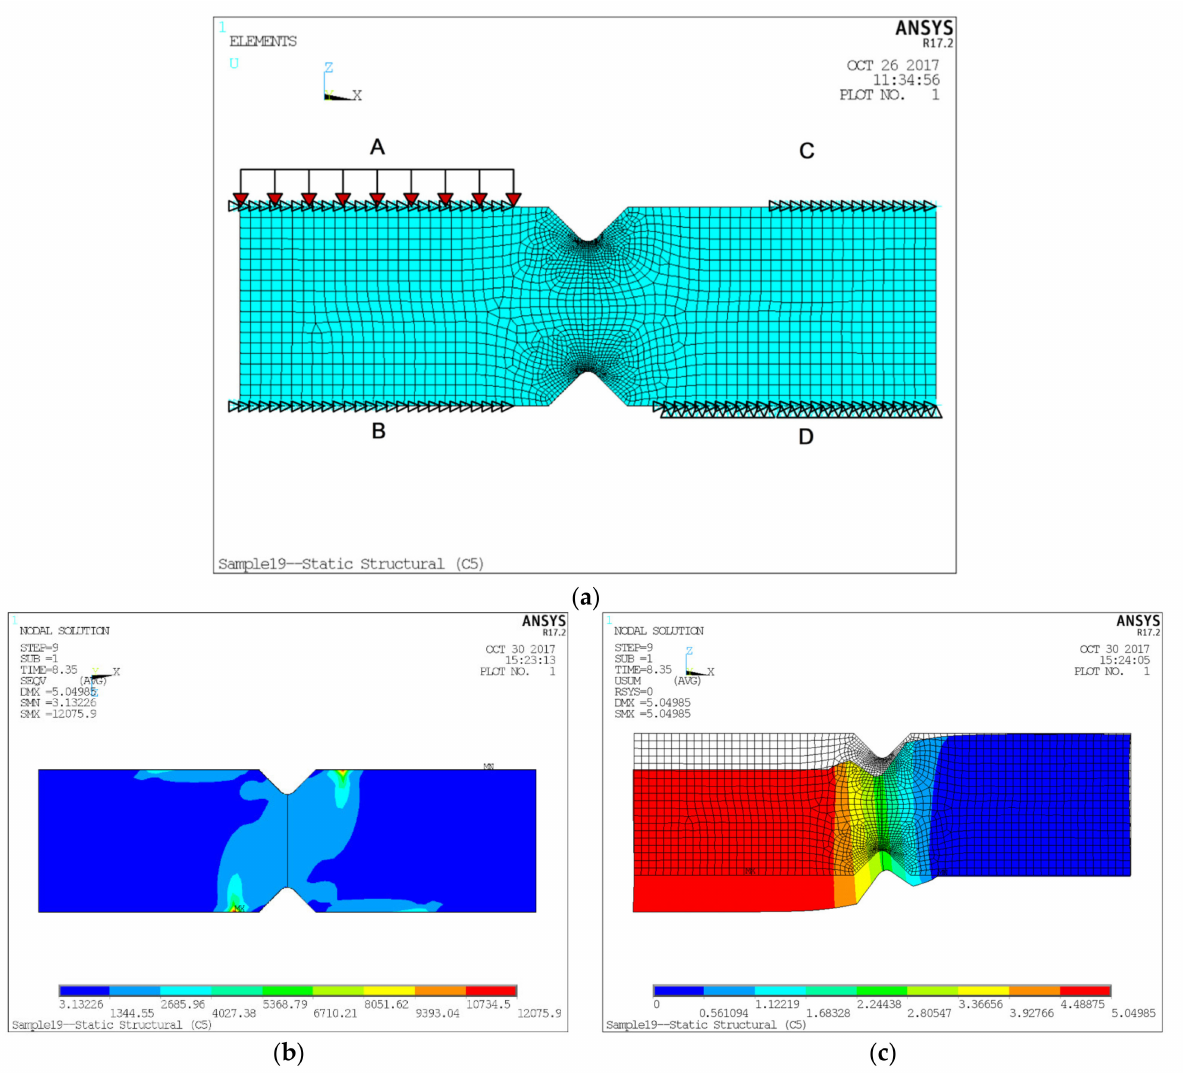
Figure 7. Example of boundary condition ( a ), equivalent stress ( b ), and shear displacement ( c ) in the calculations of the specimen for shear.